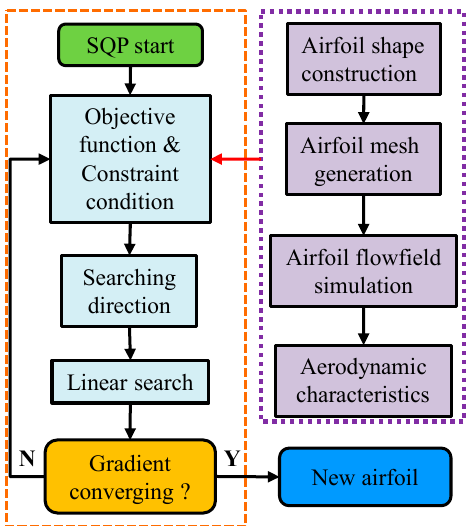
Figure A1. The optimization flow of the airfoil profile based on the SQP method.